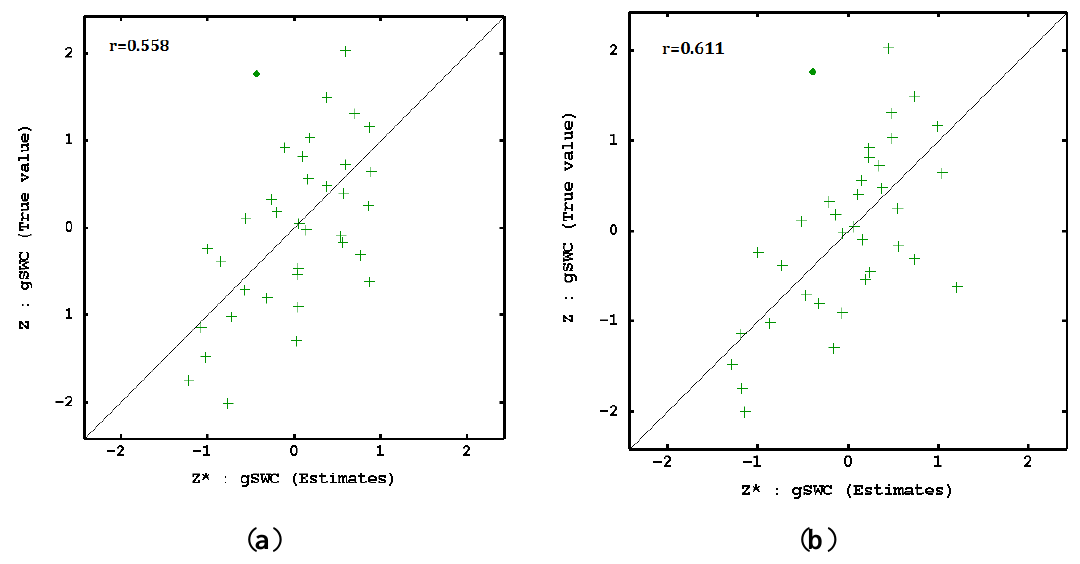
Figure 11. Scatter diagram of the measured SWC data versus the estimated values by ( a ) OK and ( b ) multi-collocated cokriging (MCCOK) through cross-validation.